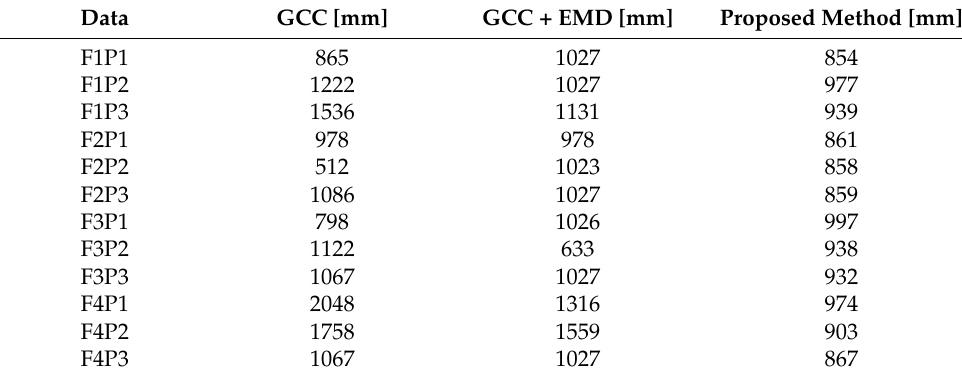
Table 3. Leak localization with the tested